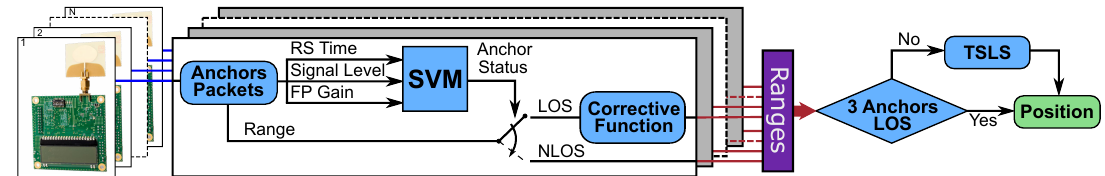
Figure 5. Schematic representation of the location tracking algorithm. The estimated range (i.e., distance) values of the anchors in NLOS conditions are used to estimate the position if the radio tag only if less than three anchor units have direct LOS to the radio